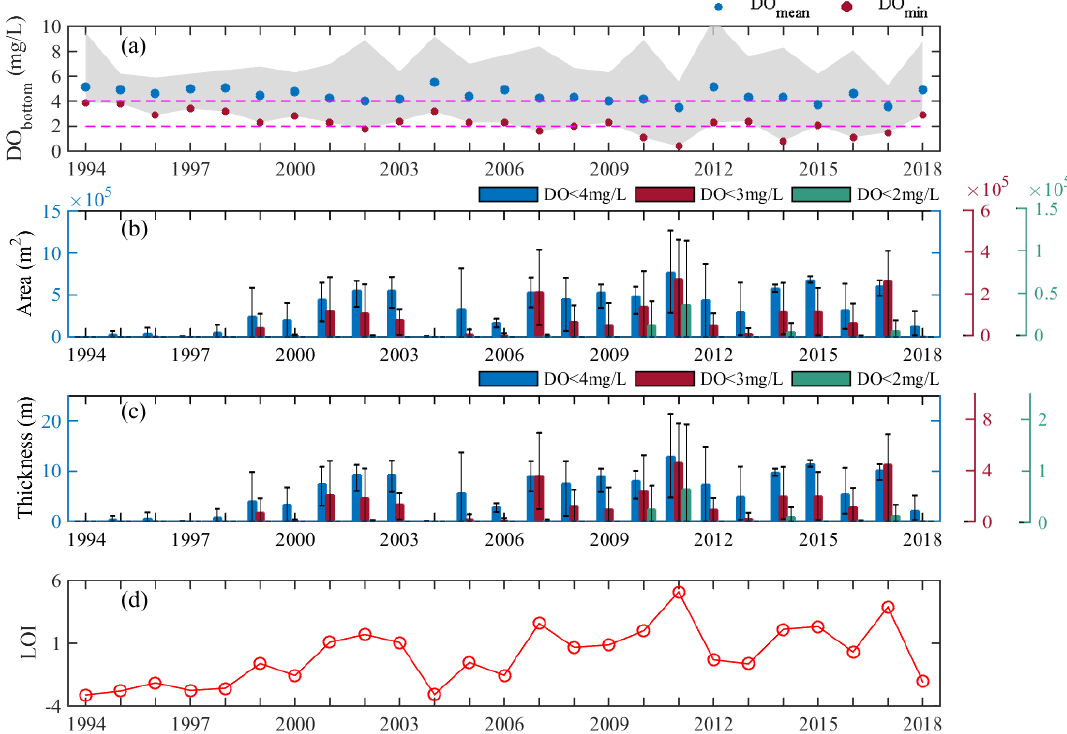
Figure 4. Interannual variations in the spatiotemporally (10 stations in June, July, and August) mean and minimum concentrations of dis- solved oxygen (DO) observed at the bottom (a) , the cross-sectional areas (b) , and layer thicknesses (c) of low-oxygen conditions, and low-oxygen index (LOI) (d) in summer during 1994–2018. Note that the gray patch in (a) represents the range of bottom DO observed at the 10 stations in 3 summer months; the colored bars in (b) and (c) show the mean values of 3 summer months, while the thin black error bars represent the range across 3 summer